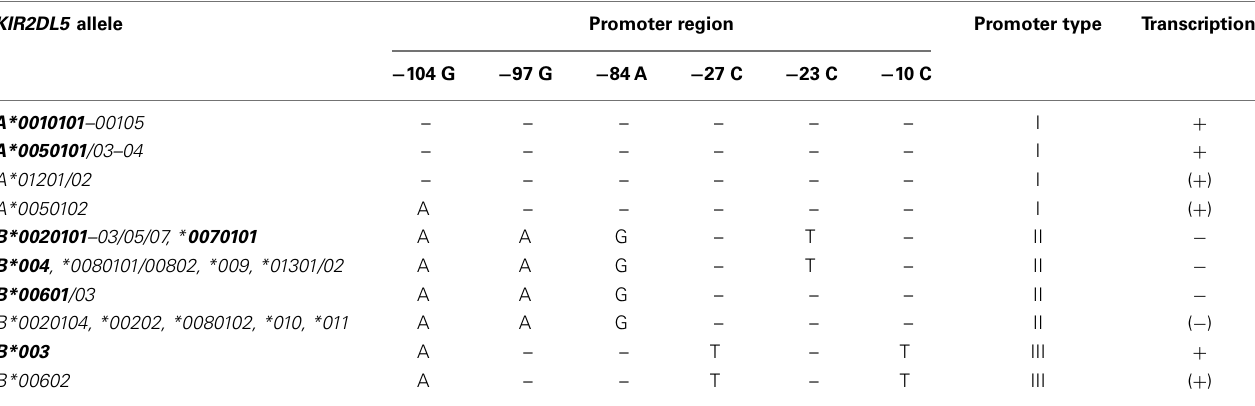
Table 3 | Comparison of the proximal promoter sequences and transcription profiles of KIR2DL5 alleles. KIR2DL5